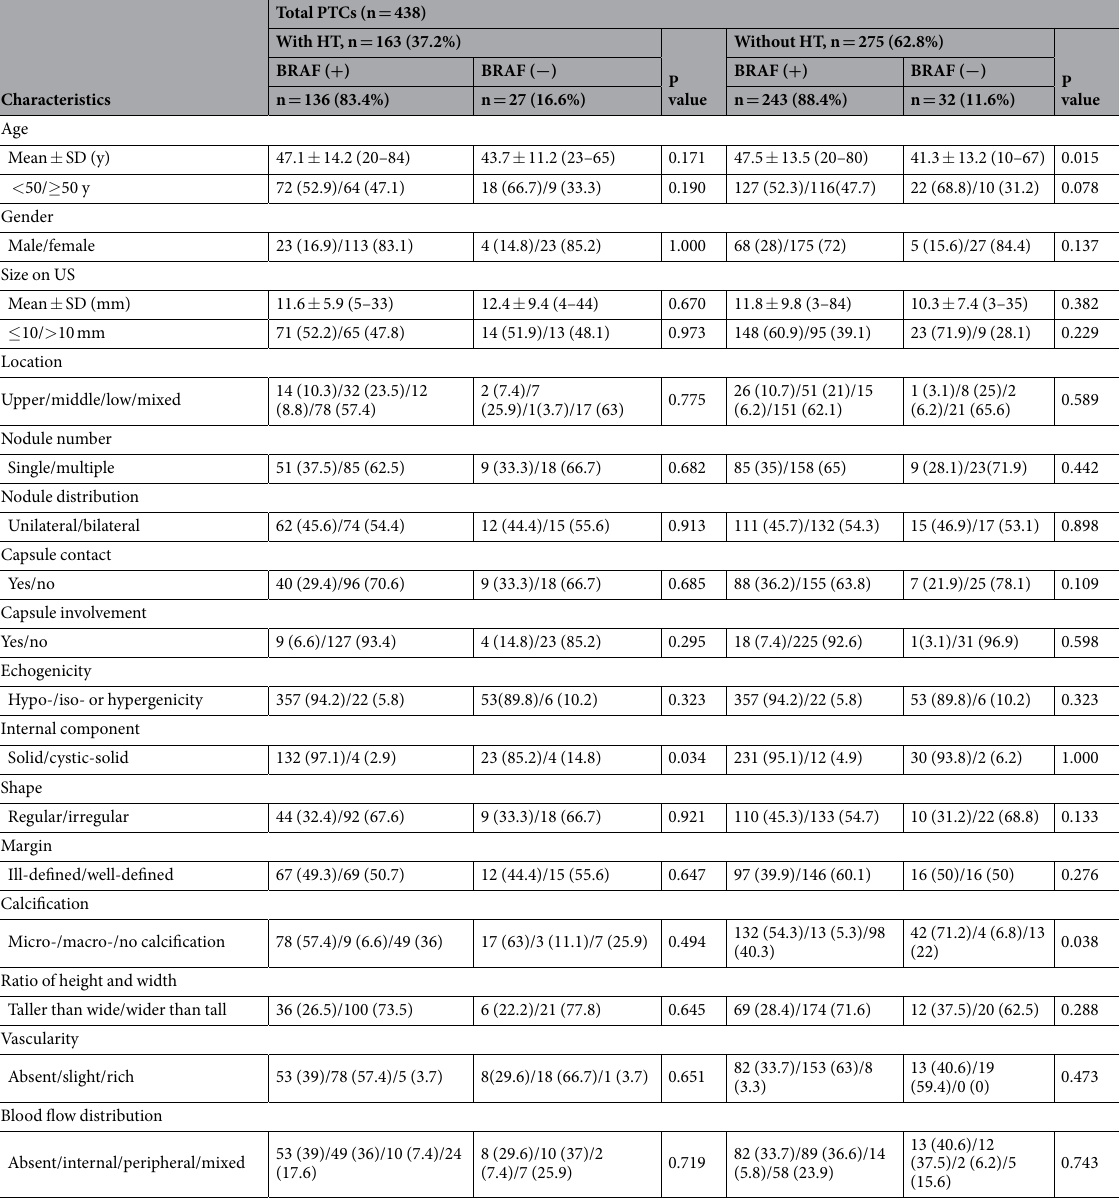
Table 3. Characteristics of the patients and US according to the BRAF mutation and concurrent HT status. # Numbers in parentheses are percentages or ranges. US: ultrasound, HT: Hashimoto’s thyroiditis, PTC: papillary thyroid